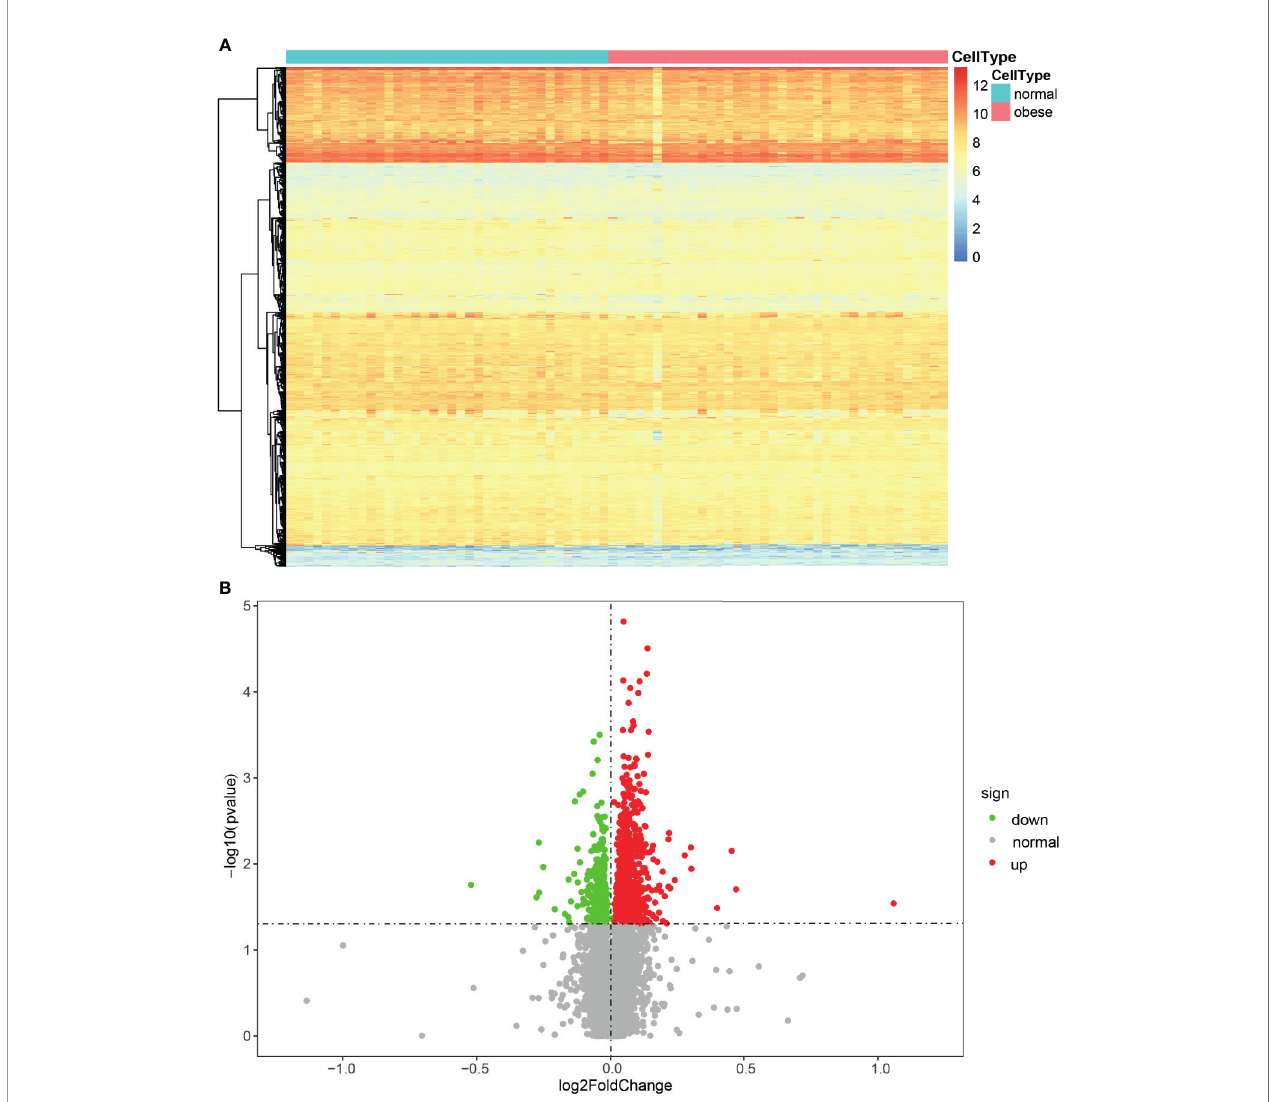
FIGURE 1 | Heat map (A) and volcano map (B) of the expression of